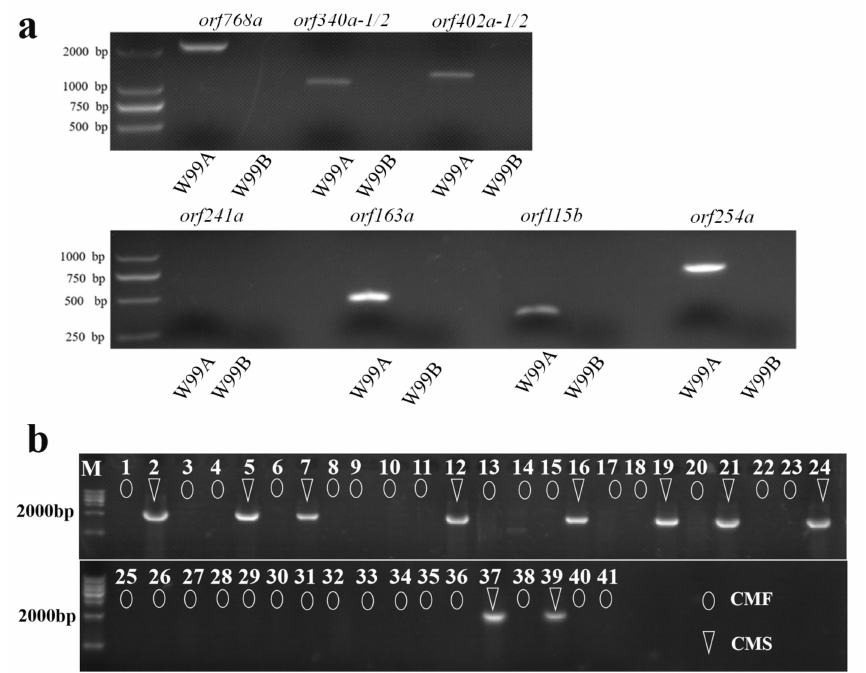
Figure 6. PCR confirmation of the specificity of ORFs for CMS celery. ( a ) RT-PCR detection of orf768a , orf340a-1/2 , orf340a-1/2 , orf241a , orf115b , orf163a , orf254a ; ( b ) CMS maker orf768a tests in 41 pepper inbred